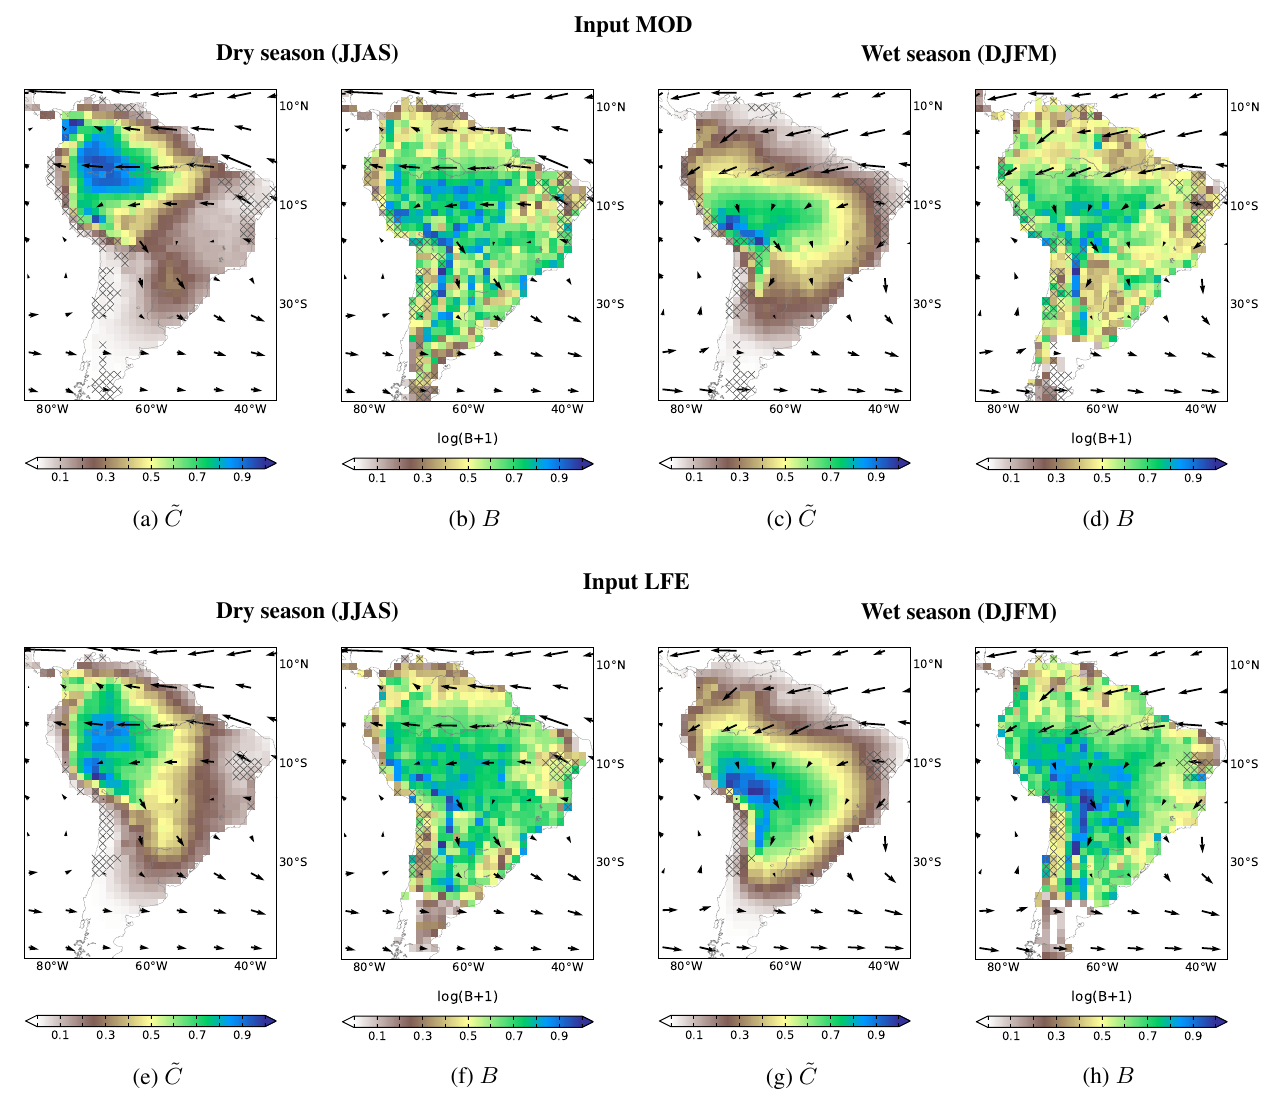
Figure 6. Results of complex network analysis. Clustering coefficient e C associated with the motif Middleman (a, c, e, g) and betweenness centrality B (b, d, f, h) . While high values of e C indicate intermediary locations where CMR allows for alternative pathways to the direct transport of moisture, high values of B indicate regions where pathways of CMR are channeled. Results are obtained using the input MOD (upper row) and input LFE (lower row) (see Table 1) and are given for the dry season (left) and the wet season (right). basin as a central sink region (see Figs. 1 and 2). In the fol- lowing, we further investigate the importance of DMR and CMR for the transport of moisture between the two basins (Figs. 7 and